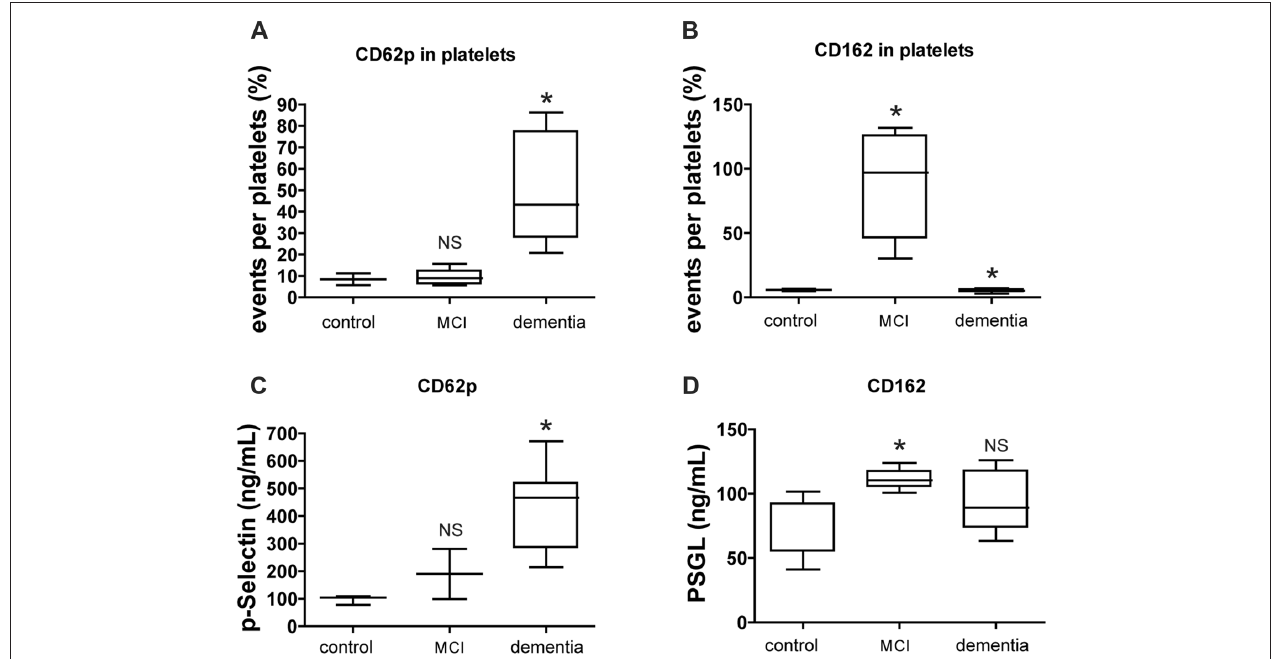
FIGURE 3 | CD62p and CD162 expression in cell surface marker and soluble level. (A,B) Level of platelet surface expressing CD62p (p-selectin) or CD162 (PSGL) was evaluated by FACS analysis. (C,D) Level of CD62p or CD162 in plasma was evaluated by ELISA. The data of FACS represents with % as an event number per gate. The result of ELISA is presented as ng/ml. Bars represent median values, and the error bar, the standard deviation. ∗ p < 0.05 vs. control group. NS, not significant.